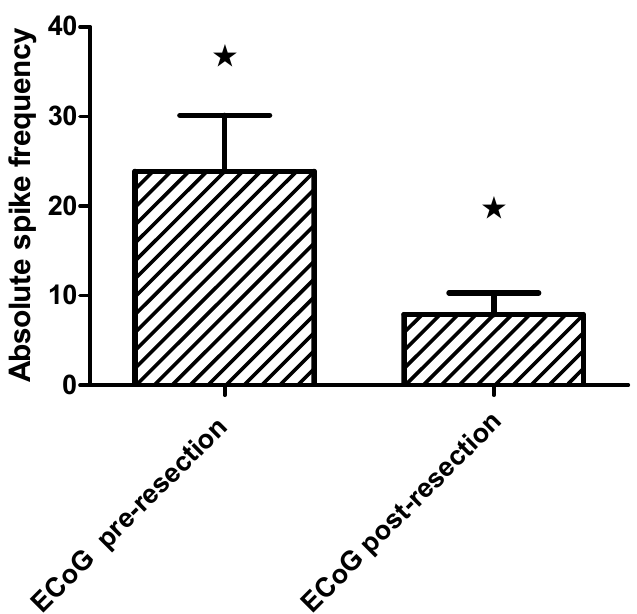
Figure 3 Bar grah showing absolute spike frequency on the pre and post-resection intraoperative electrocorticography (mean and standard error SE) in extratemporal epilepsies patients (Wilcoxon matched pairs test, *p=0.002).